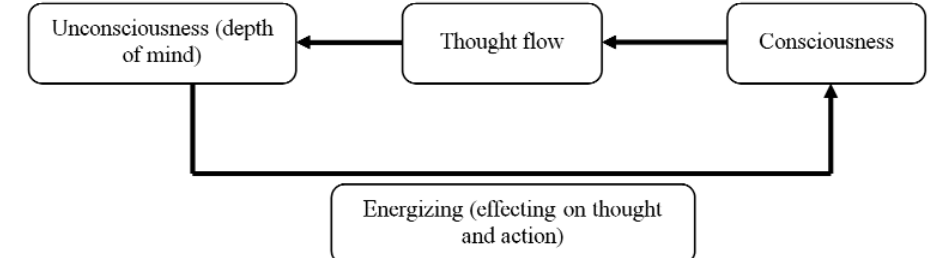
Fig. 3. Quantum thinking